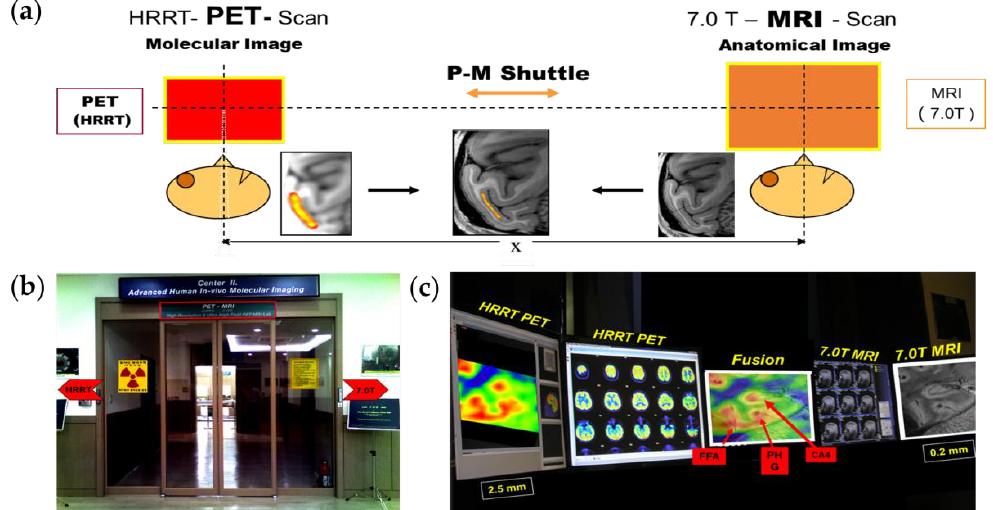
Figure 4. ( a ) Conceptual diagram of the high-resolution PET – MRI fusion imaging system and the developed PET – MRI system with HRRT and 7.0T MRI. ( b ) A gate of the PET – MRI fusion system using HRRT-PET and 7.0T MRI. The shuttle is visualized in the middle of the chamber. ( c ) Results are displayed on the PET – MRI console showing the PET images on the left and the MR images on the right. In the middle, a PET – MRI fusion image is shown. P-M; PET-MRI, FFA; fusiform face areas, PHG; parahippocampal gyrus, CA4; cornu ammonis 4. Reprinted with permission from Cho et al., 2008, JOHN WILEY AND SONS [49].